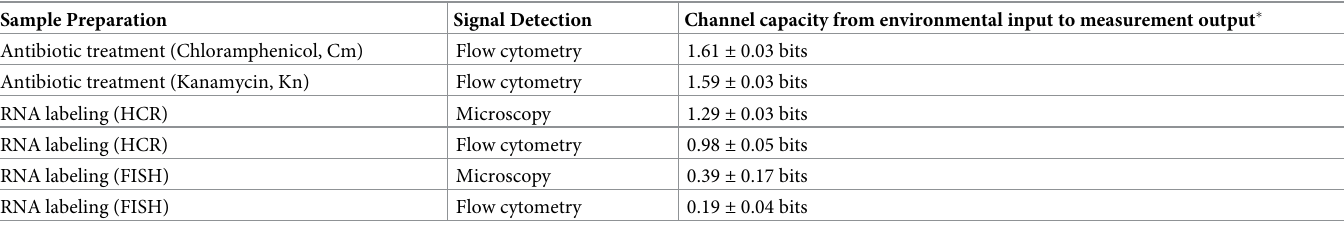
Table 3. Channel capacities of single-cell fluorescent protein